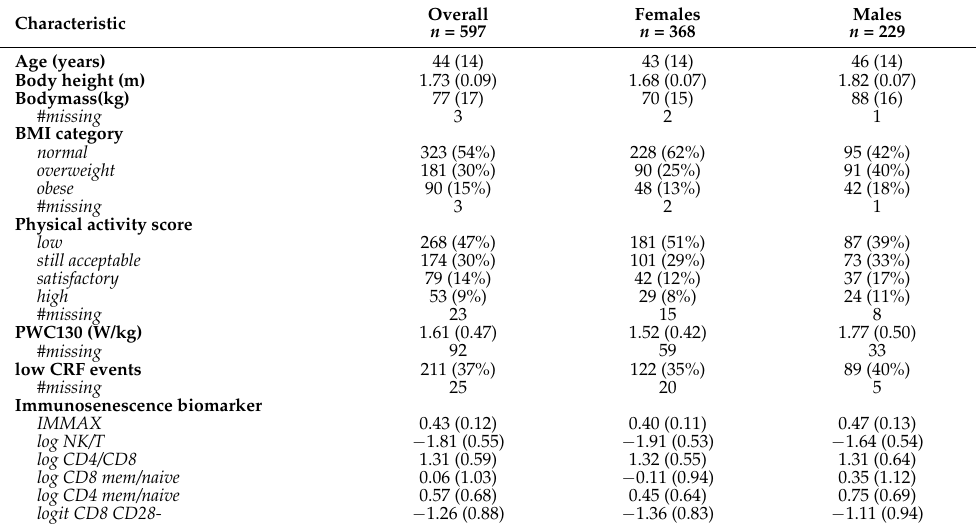
Table 1. Sample characteristics stratified by sex, and summarized by mean (SD) for continuous data and by frequency (percentage) for categorical observations,